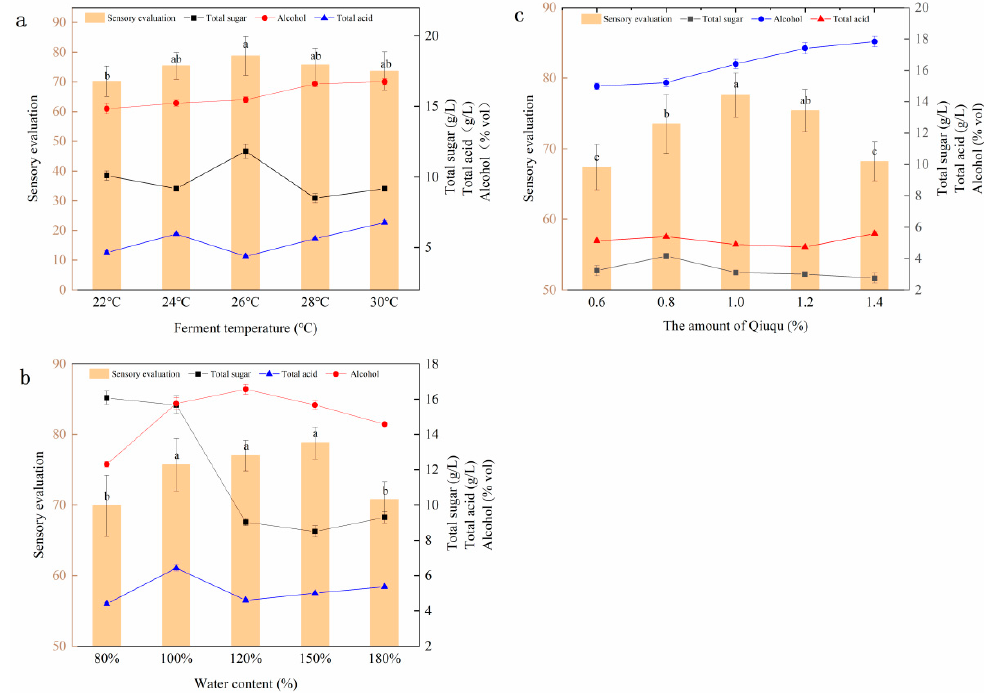
Figure 1. Effect of a single factor on the quality of SRW. ( a ) Effect of fermentation temperature on the quality of SRW, ( b ) effect of water content on the quality of SRW, and ( c ) effect of Qiuqu addition amount on the quality of SRW.